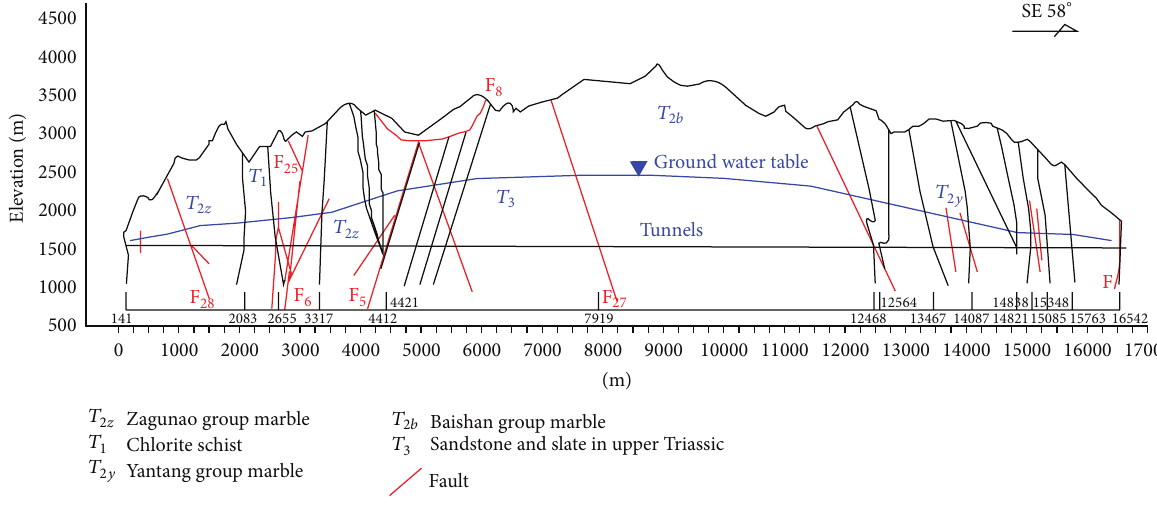
Figure 3: Geological profile along the tunnel